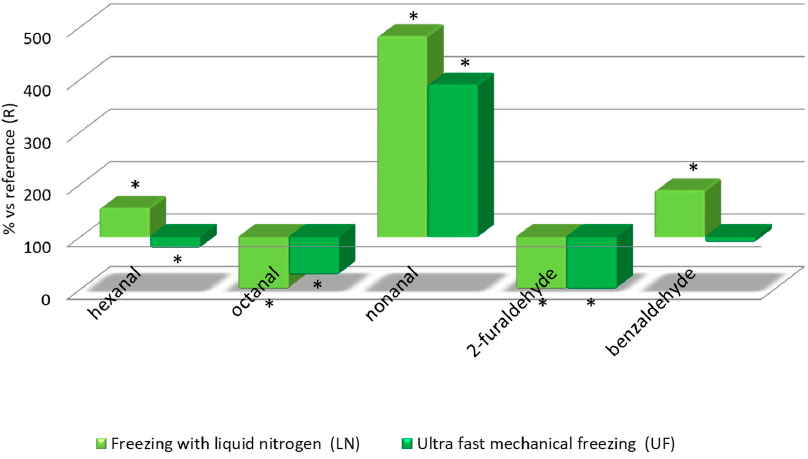
Figure 4. Relative levels of volatile alcohols in the three wine types: Relative values for LN and UF vs R. *Significant difference vs the R wines ( p -value < 0.05).